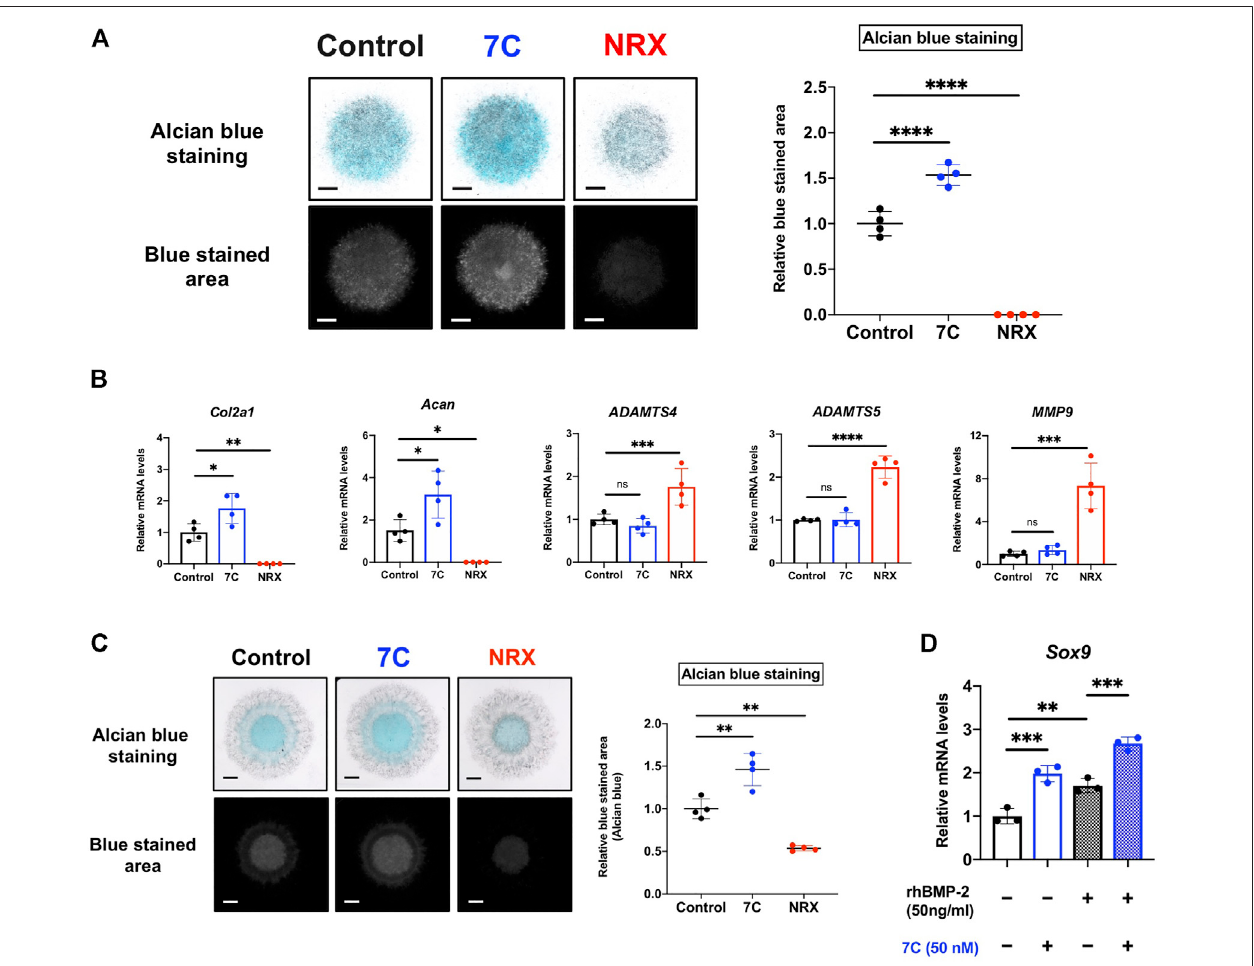
FIGURE6| EffectofRAR γ agonist/antagonistonATDC5cellsandMSCs. (A) AlcianbluestainingofATDC5cellsinmicromass(scalebar=1 mm).Thebluestained area was extracted using ImageJ (version 1.52q, U. S. National Institutes of Health; https://imagej.nih.gov/ij/) ( n = 4 per group). (B) Quantitative RT-PCR analysis of ATDC5cellsculturedinchondrogenicmediumsupplementedwithBMP-2(20 ng/ml)and7C(50 nM)orNRX(100 nM)( n =4pergroup). (C) AlcianbluestainingofMSCs in micromass (scale bar = 1 mm). The blue stained area was extracted using ImageJ ( n = 4 per group). (D) The gene expression level of Sox9 in MSCs cultured in chondrogenicmedium. Sox9 expression wasupregulatedby7C,evenintheabsenceofBMP-2( n =3per group). * p < 0.05,** p < 0.01, *** p < 0.001and **** p < 0.0001 and ns, not signi fi cant.